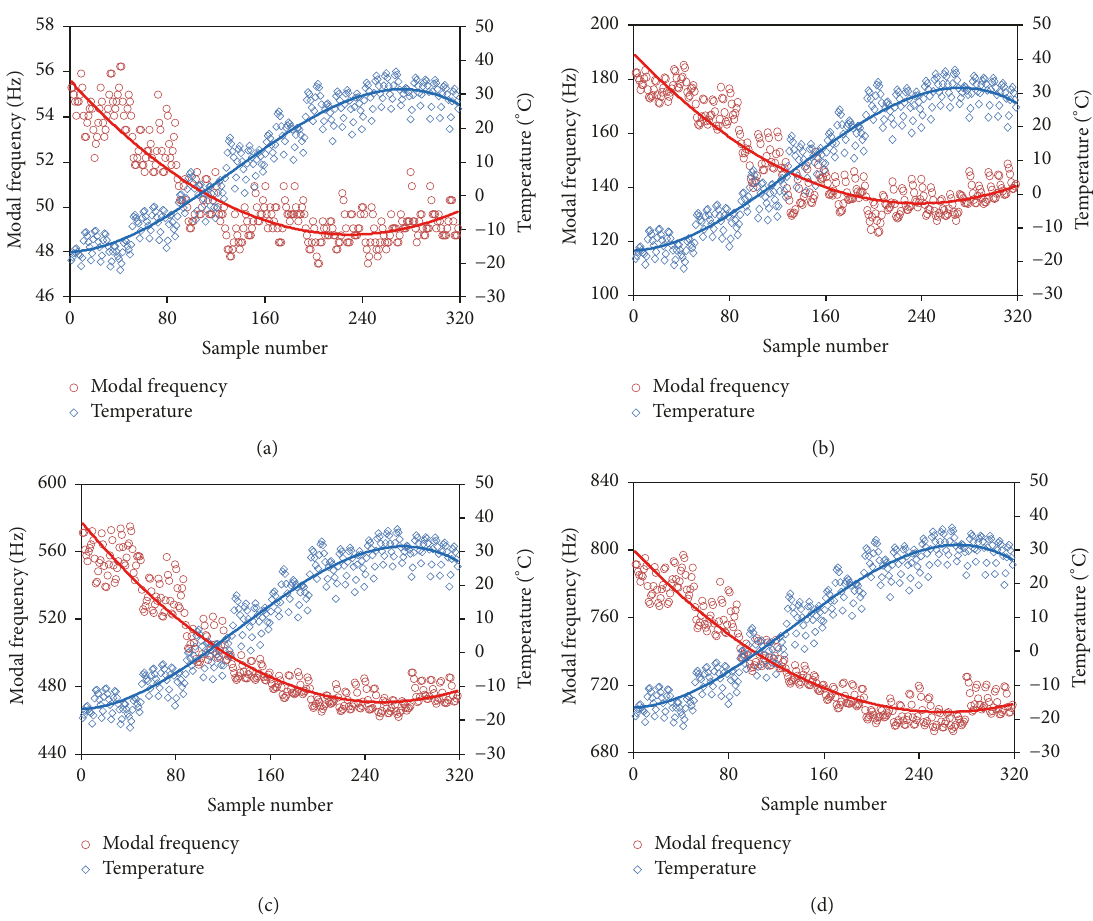
Figure 6: Modal frequencies (red) versus average temperature (blue) (thick lines represent the fitting curve). (a) 1st mode; (b) 2nd mode; (c) 3rd mode; (d) 4th